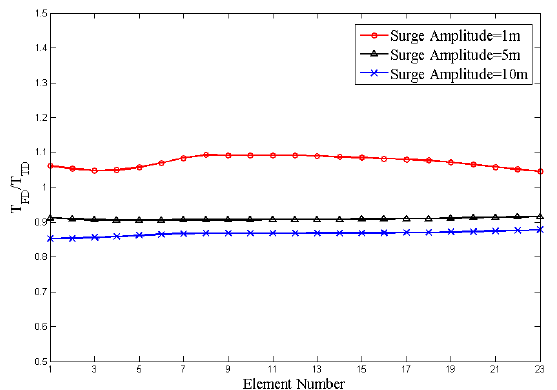
Figure 15. The ratio of dynamic tension amplitude in the frequency domain and time domain under harmonic excitation.